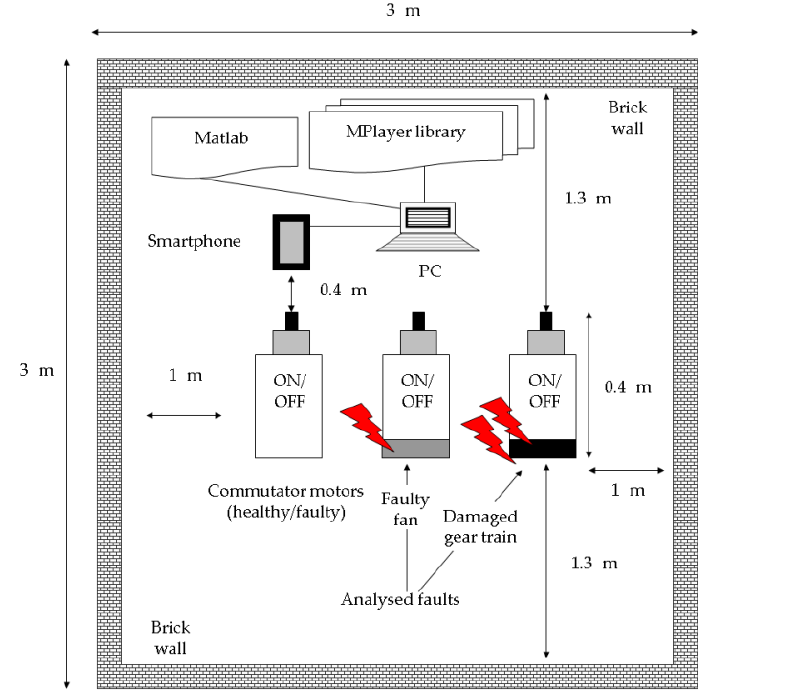
Figure 2. Diagram of experimental setup of the measurements using smartphone (by A. Głowacz un- der CC BY 4.0, source: [15]). Healthy and faulty motors were placed next to a smartphone microphone. Recorded data were transfered to a PC and processed with additional software, such as